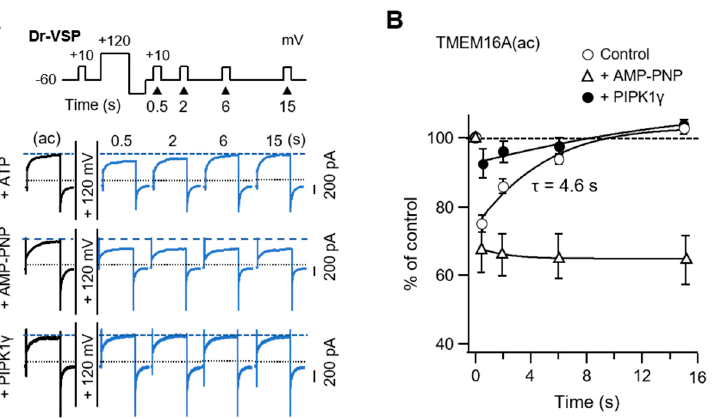
Figure 5. TMEM16A(ac) current recovery from inhibition by PI(4,5)P 2 depletion. ( A ) Current traces for TMEM16A(ac) in control cells intracellularly perfused with 3 mM ATP (top), cells perfused with AMP-PNP (middle), and cells expressing PIPKI γ with 3 mM ATP (bottom) before and after a +120 mV 1 s depolarizing pulse. TMEM16A(ac) currents were measured at +50 mV at the indicated times after the depolarizing pulse. Dotted lines indicate a zero current; dashed lines indicate the initial TMEM16A(ac) current before the depolarizing step. ( B ) Summary time courses of TMEM16A(ac) current recovery in response to PI(4,5)P 2 depletion by Dr-VSP activation (ATP, n = 6; AMP-PNP, n = 5; PIPKI γ , n = 5).